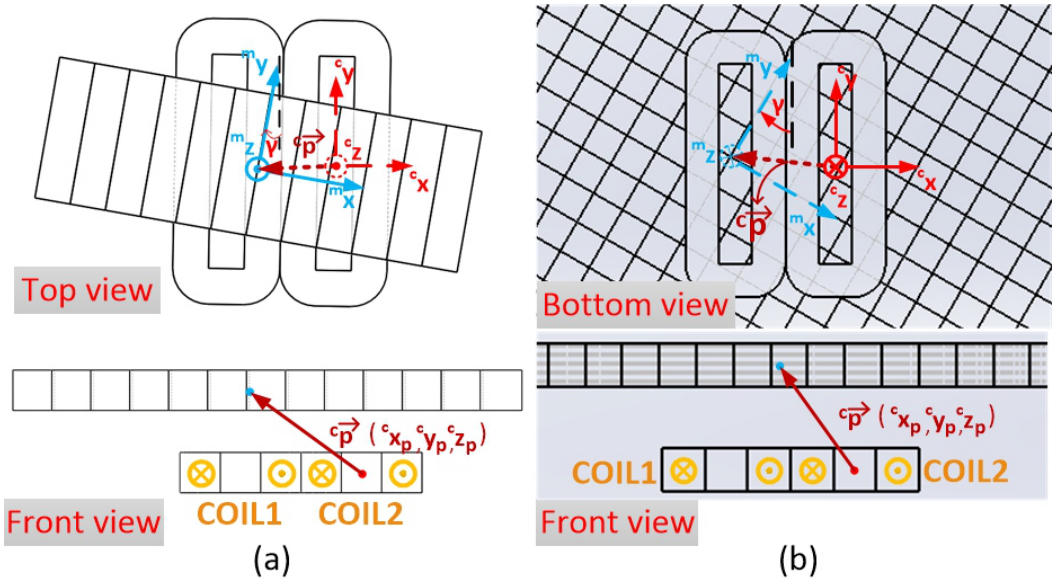
Figure 4. Structure prototype of the actuating unit. ( a ) 1D Halbach array actuating unit. ( b ) 2D magnetic field actuating